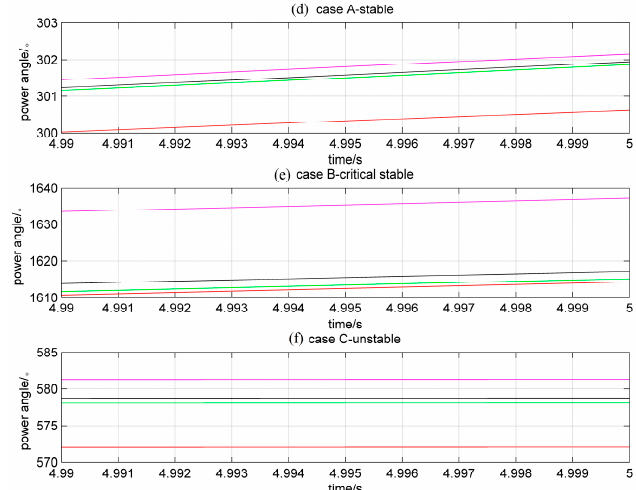
Figure 4. Simulation results for the power angle using different integration algorithms. ( a ) power angle curves using different integration algorithms for case A; ( b ) power angle curves using different integration algorithms for case B; ( c ) power angle curves using different integration algorithms for case C; ( d ) partial enlargement of ( a ); ( e ) partial enlargement of ( b ); ( f ) partial enlargement of ( c ).